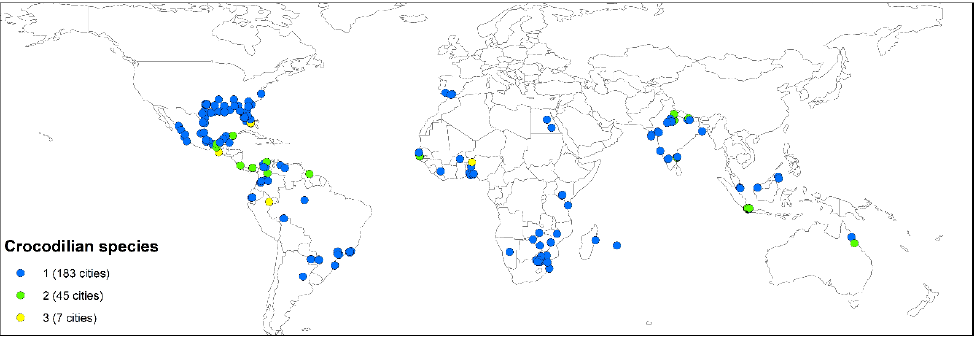
Figure 4. Number of freshwater lizard species sighted between January 2013 and April 2018 within 50 km of a city with a population of more than 100,000.